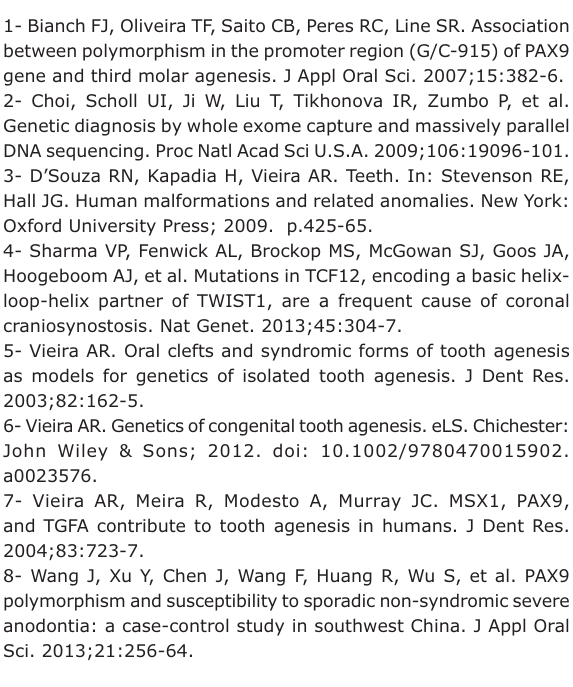
Figure 1- Allele and genotype frequencies of the